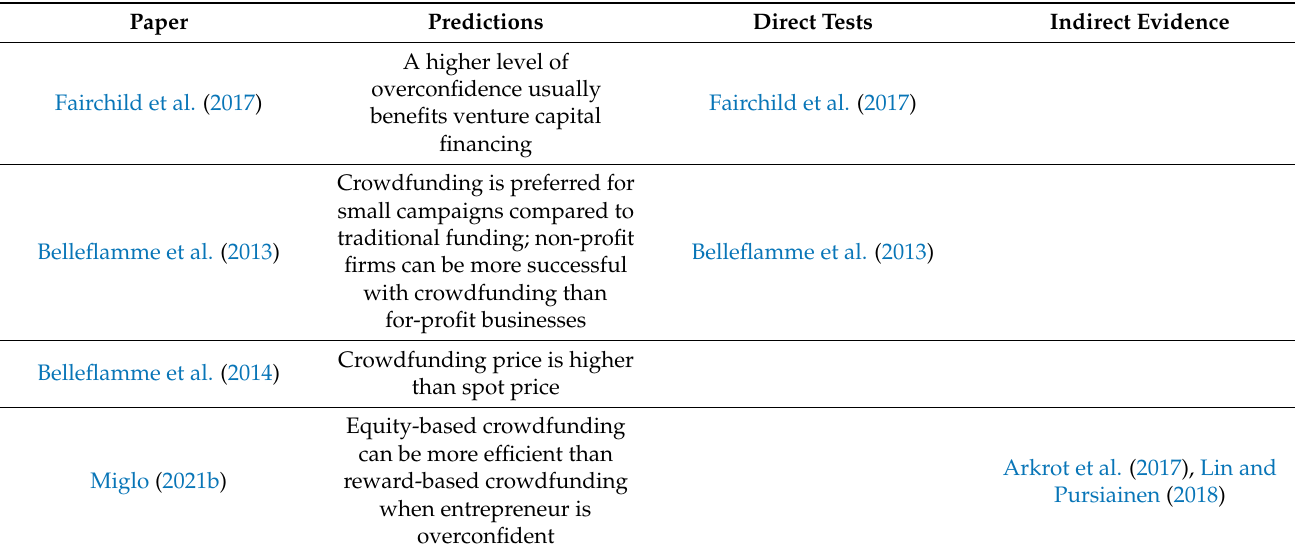
Table 8. Behavioural finance-based theories of crowdfunding and token